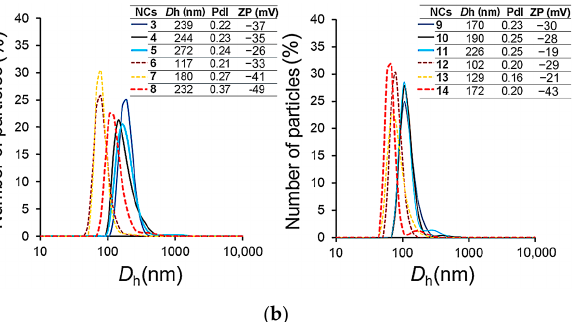
Figure 1. ( a ) TEM images of Fe 3 O 4 @SiO 2 MNP-based composite materials 3 – 8 obtained using 1.5, 3.0, and 5.0 mol equiv. TEOS, respectively. ( b ) DLS data for colloidal solutions of NCs 3 – 14 .